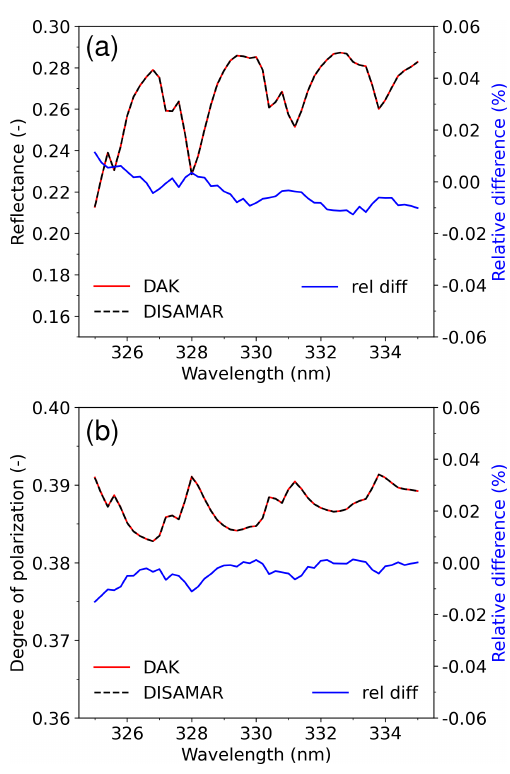
Figure 7. Comparison of DISAMAR and DAK simulations of TOA reflection spectra between 325 and 335nm: (a) reflectance and (b) degree of linear polarization. The relative difference is defined as (DISAMAR − DAK)/DAK (in percent). The wavelength step in the spectra is 0.2nm, and no ISRF convolution is performed. The geometry is as follows: nadir view with a solar zenith angle of 60 ◦ . Surface albedo is